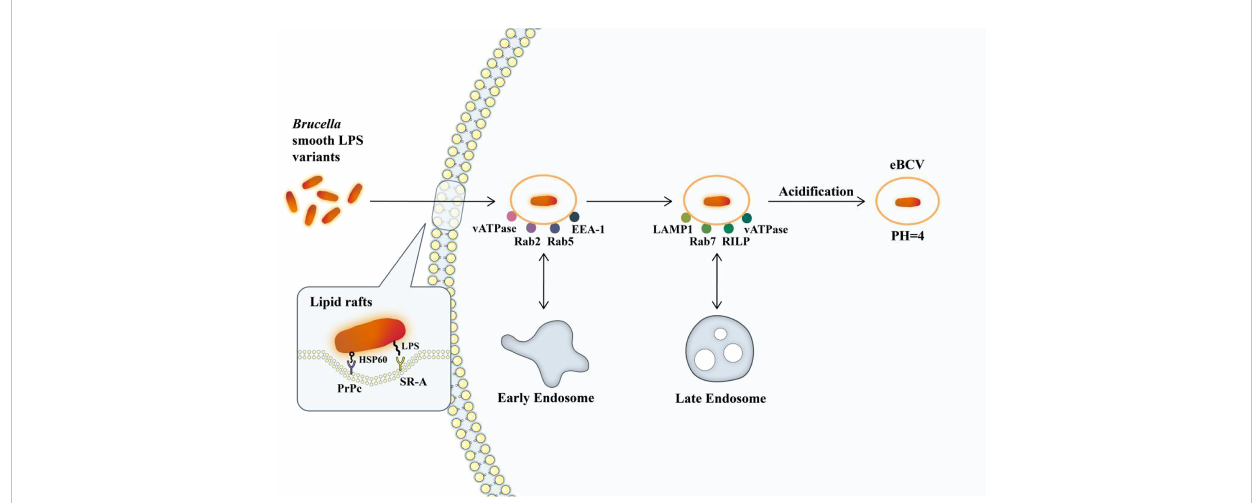
FIGURE 1 The formation of eBCV. Brucella enters macrophages via lipid rafts. Hsp60 and Brucella LPS bind to PRPC and SR-A receptors on lipid rafts. Brucella enters the cell and remains in the membrane envelope cavity, forming BCV containing Brucella . It interacts with early endosomes to obtain small GTPase Rab5 and early endosomal antigen (EEA-1) and subsequently obtains markers of late endosomes, such as membrane proteins recombinant lysosomal associated membrane protein 1 (LAMP1) and small GTPase Rab7. It will then be acidi fi ed, and the pH will reach 4, which is essential for the survival of Brucella and for the intracellular expression of the VirB T4SS (Porte et al., 1999; Boschiroli et al., 2002). The single arrows represent the fl ow of Brucella intracellular processes, and the double arrows represent